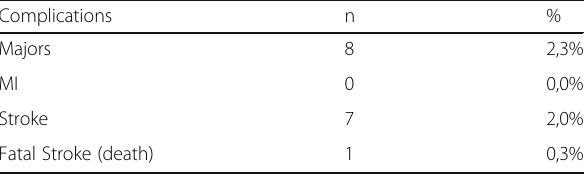
Table 2 Peri-procedural